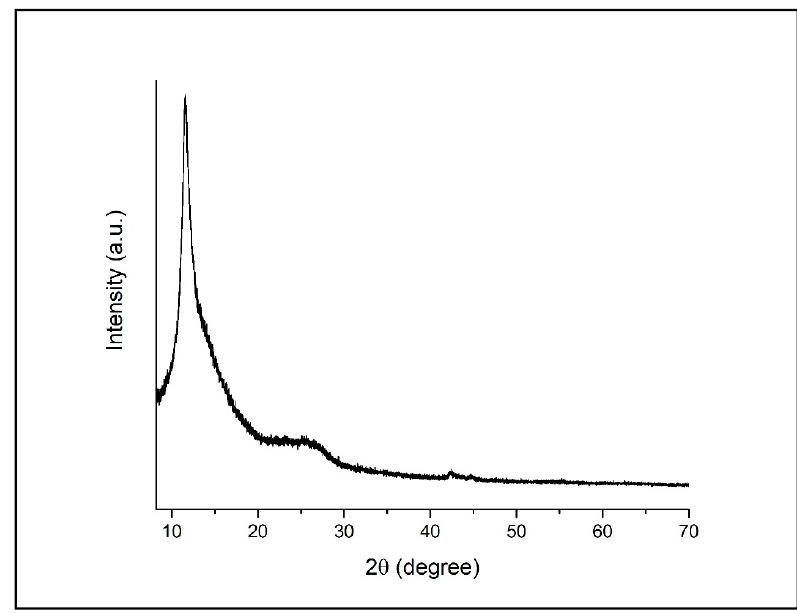
Figure 2. XRD patterns of GO.